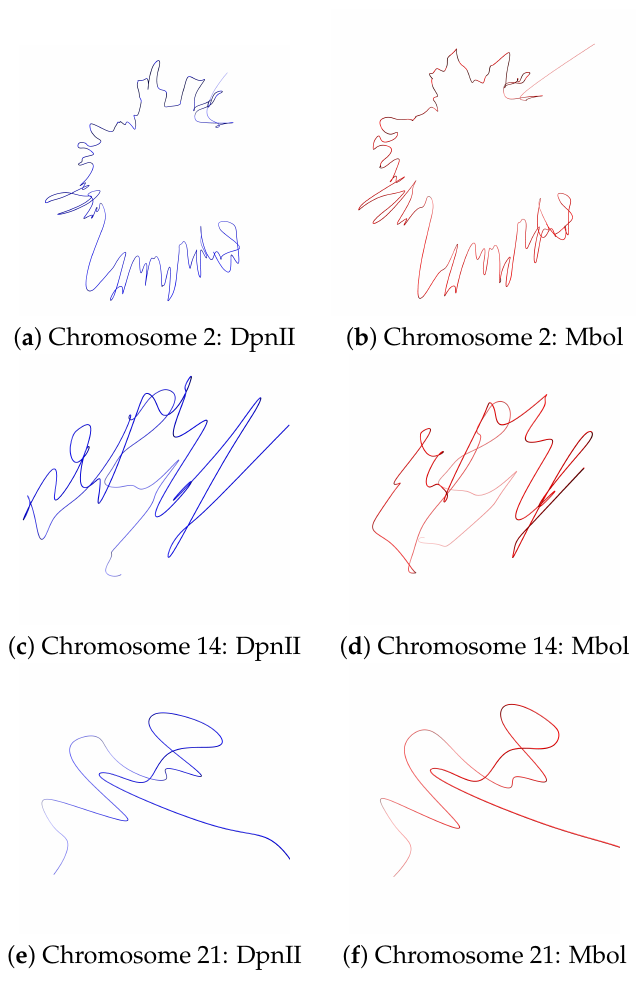
Figure A2. 3D structures produced by CBCR on the DpbII and Mbol restricted maps of GM12878 at 1